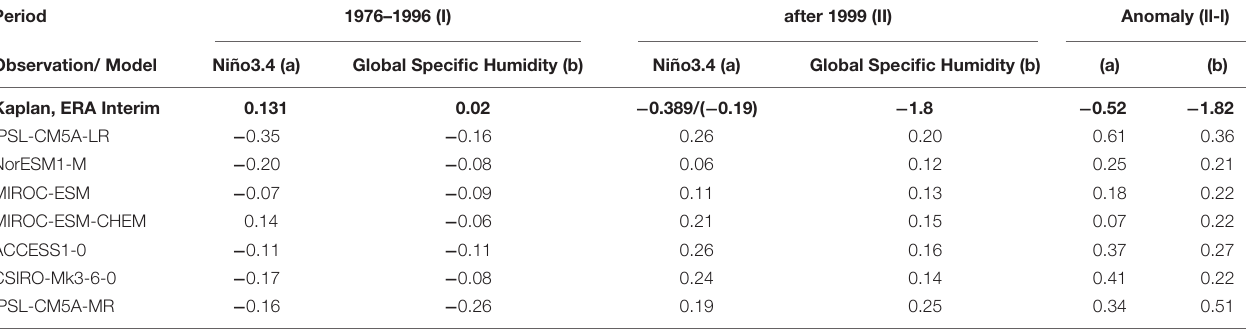
TABLE 1 | Variation of Niño 3.4 and Global Specific Humidity (gm/kg) anomaly in abrupt warming period (1976–1996) and warming trend slowdown period. Period